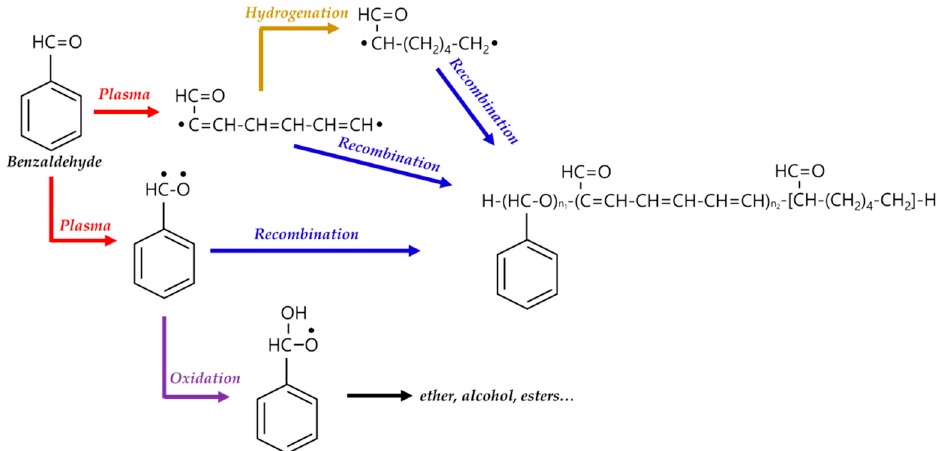
Figure 16. APP polymerization mechanisms, from a chemical point of view, related to the formation of benzaldehyde-based polymer films.